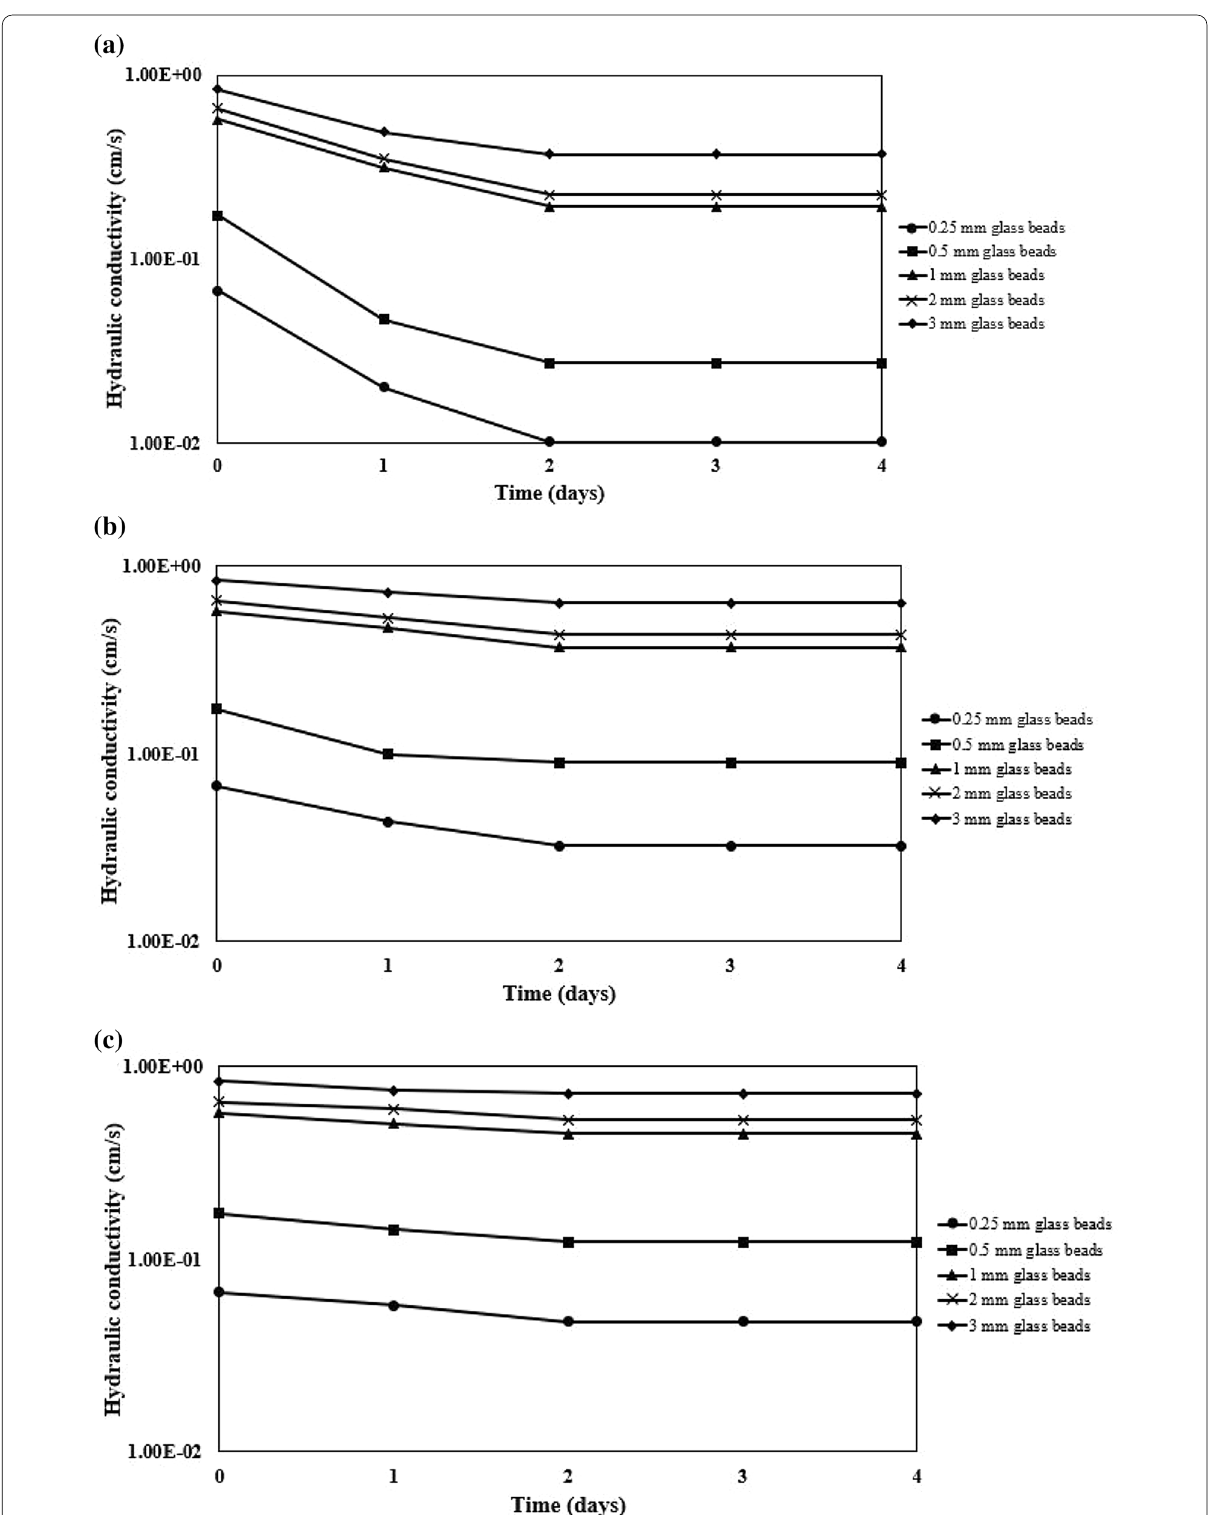
Fig. 4 Change in hydraulic conductivity in time for the experiments conducted with a OD 600 2.25, b OD 600 0.75, and c OD 600